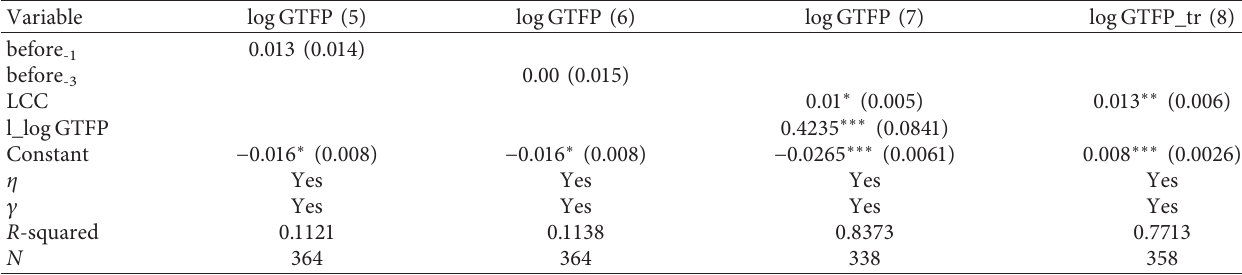
Table 5: Other robustness test result.